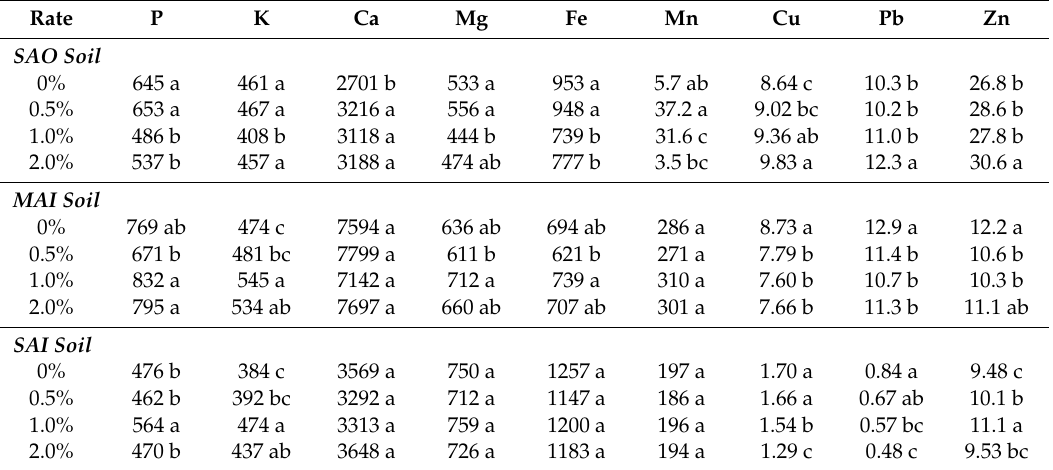
Table 4. Mean values of soil fertility characteristics (Mehlich 3 extraction) (mg / kg) of four treatments of three soils after 434-day incubations 1